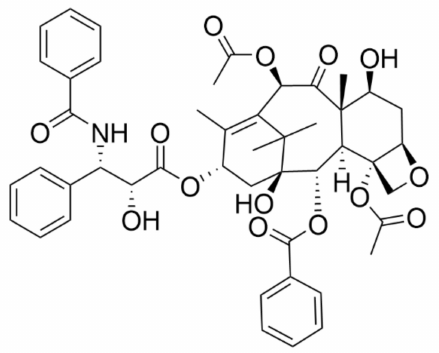
Figure 1. Chemical structure of paclitaxel.